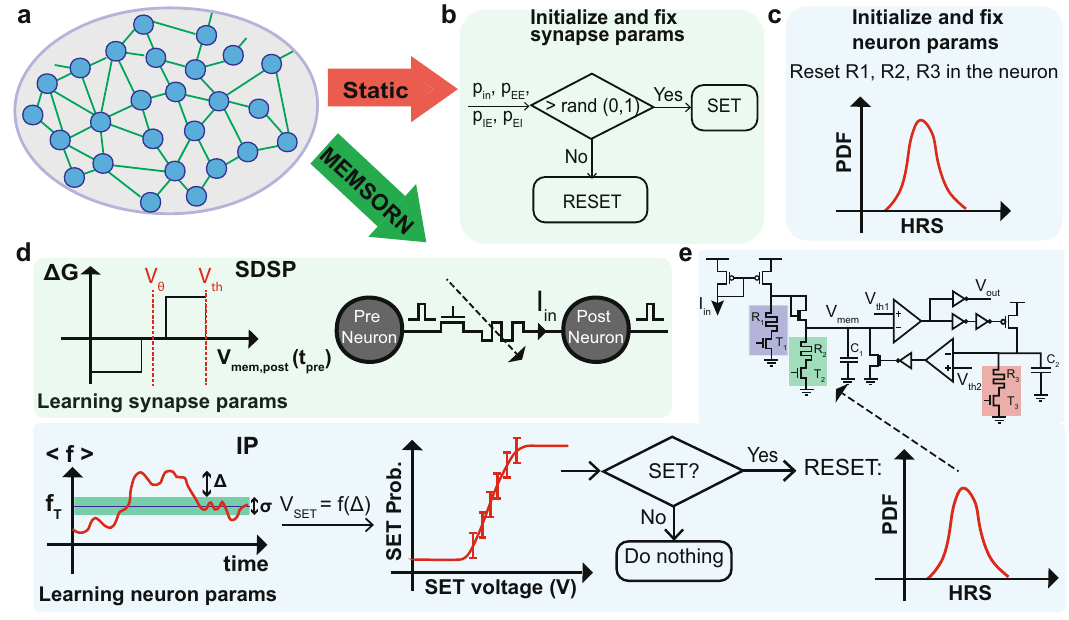
Fig. 3 | Technologically plausible algorithms for static and MEMSORN net- works. a ASpiking RecurrentNeuralNetwork(SRNN)withexcitatoryconnections. b , c Synapse and neuron parameters for the static network. Both values are fi xed after an initialization process. b Synaptic parameters are initialized based on comparing the probability of different connections with a random number. c Neuronal parameters are initialized by resetting the memristors R 1 , R 2 and R 3 which is equivalent to sampling from a log-normal distribution around a mean resistance that is a function of the reset voltage. d , e Synaptic and neuron para- metersfor MEMSORN network. Both parametersare learned throughout the input